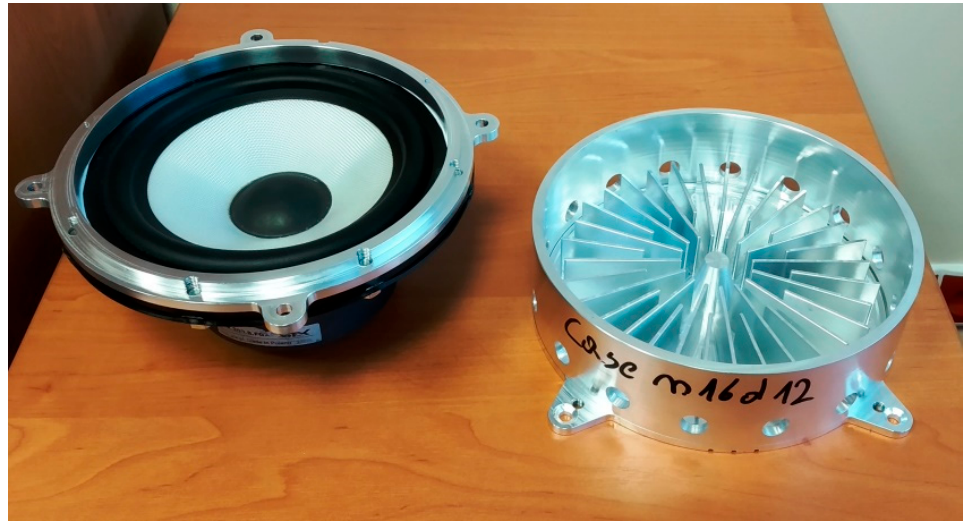
Figure 1. Heat sink integrated with the enclosure of SJA.